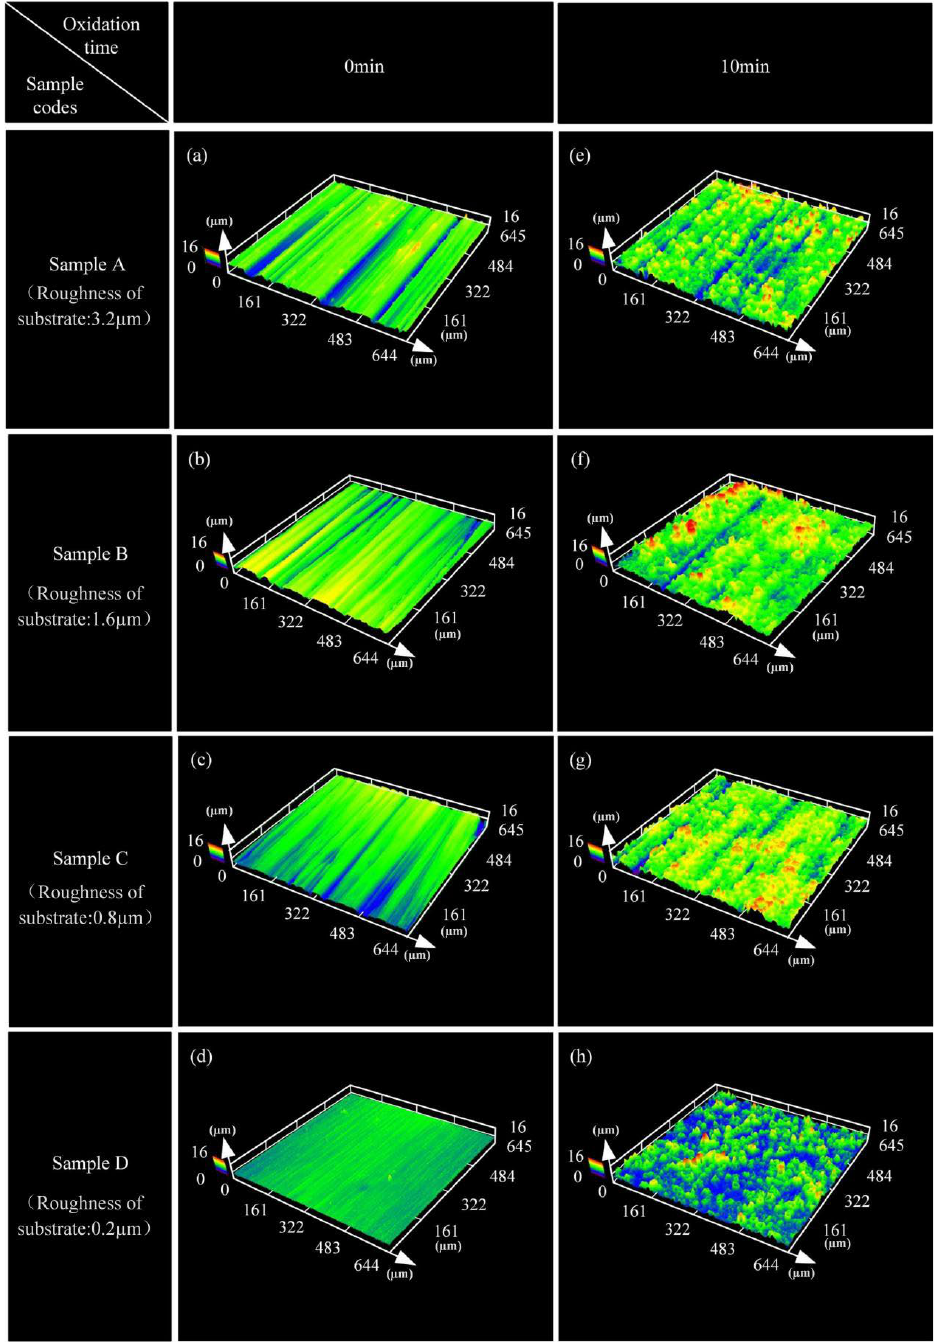
Figure 4. 3D morphologies of the substrate ( a – d ) and PEO-coated samples ( e – h ).